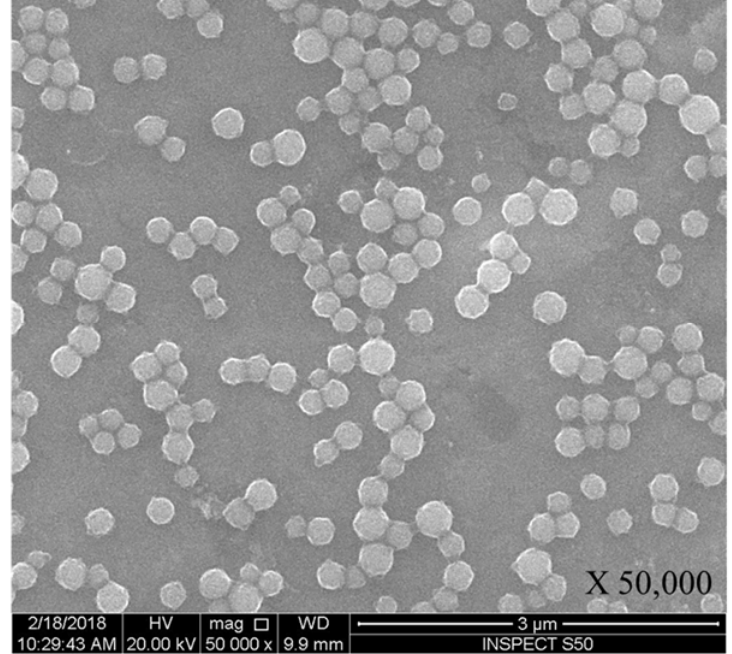
Figure 1. Spherical structure of fluorescent magnetic submicronic polymer (FMSP) ‐ nanoparticles showing through scanning electron microscopy (SEM) with 50,000× magnification.